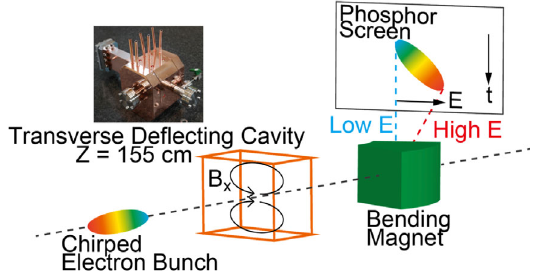
FIG. 8. Schematic of the longitudinal phase space measure- ment. The horizontal magnetic field in the TDC streaks the electron bunch vertically and the bending magnet disperses the electrons horizontally.